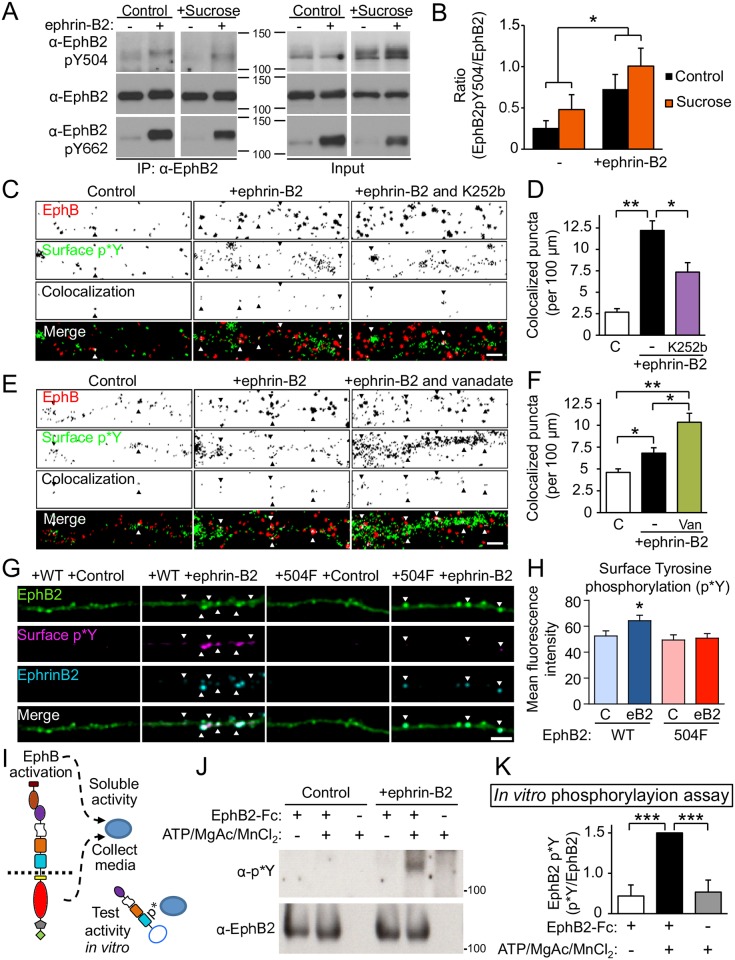
Phosphorylation of Y504 occurs on the surface of neurons.(A) Untransfected cultured rat cortical neurons treated with either ephrin-B2 (+) or control reagents (-) for 45–60 minutes and with either control (C) or sucrose (450 mM, for 15 minutes). In the left panels, EphB2 was immunoprecipitated and blots were probed (listed top to bottom) for EphB2 p*Y504, EphB2, and EphB2 p*Y662. Right panels show neuronal lysates probed in the same manner from the same experiment. (B) Quantification of the ratio of EphB2 Y504 to total EphB2 (control [n = 7] and sucrose [n = 5]; * p < 0.01, 2-factor factorial ANOVA). (C) Images of dendrites stained in live neurons for phosphotyrosine and ephrin-B binding sites (EphBs). Day in vitro (DIV) 7–10 rat cortical neurons were treated with control reagents, activated ephrin-B2 alone, or with 10 μM K252b for 45 minutes and then α-phosphotyrosine antibodies (PY99, p*Y) were added to cells at room temperature for 10 minutes. Neurons were fixed and processed for immunostaining. High-contrast images are shown. Top panels were stained for EphBs, middle panels were live-cell stained for α-p*Y and colocalization, and bottom panels show merged images. In merged panels, red staining indicates surface EphBs, green indicates p*Y, and white indicates colocalization. Arrows indicate examples of colocalized EphB and surface p*Y staining. Scale bar = 2 μm. (D) Quantification of the effects of ephrin-B2 treatment and K252b on surface p*Y staining of EphBs. n = 32, 34, and 34 fields from 3 independent experiments for control (C), ephrin B2-Fc treatment, and K252b plus ephrin-B2-Fc treatment, respectively (*p < 0.01, **p < 0.0001, ANOVA followed by Dunn’s multiple comparison test). (E) Images of live-cell stained dendrites as in (C) but treated with ephrin-B2 and vandadate (1 mM for 10 minutes). Scale bar = 2 μm. (F) Quantification of the effects of ephrin-B2 treatment and vanadate treatment on surface p*Y staining of EphB (*p < 0.01, ANOVA followed by Dunn’s multiple comparison test, n = 44 fields from 4 independent experiments). (G) DIV 7–10 rat cortical neurons transfected at DIV 3 with td-Tomato and enhanced yellow fluorescent protein (EYFP)-tagged EphB2 wild type (WT), Y504E, or Y504F were treated with either control reagents or activated ephrin-B2 for 45 minutes and then α-phosphotyrosine antibodies (PY99, p*Y) were added to cells at 37°C for 10 minutes. Neurons were fixed and processed for immunostaining. High-contrast images are shown. Top panels were stained for EYFP-tagged EphB2, upper middle panels were live-cell stained for α-p*Y, and lower middle panels were stained for Fc (control Fc or ephrin-B2). Bottom panels show merged images. Arrows indicate examples of triple colocalized puncta. Scale bar = 3 μm. (H) Quantification of the mean fluorescence intensity of surface phosphotyrosine for each condition (n = 20 fields from 3 independent experiments, *p < 0.05, ANOVA followed by Dunn’s multiple comparison test). (I) Experimental approach for EphB2 extracellular phosphorylation activity assay in neurons is illustrated. (J) Tyrosine kinase activity in ephrin-B2–treated conditioned artificial cerebrospinal fluid (ACSF) in cultured rat cortical neurons. Medium of cultured neurons was replaced with ACSF, and neurons were treated with ephrin-B2 or control reagents for 45–60 minutes. The extracellular domain of EphB2 fused to the Fc fragment of immunoglobulin G or control reagent was added to filtered ACSF. To activate the activity released from cultured neurons into ATP, MgAc and MnCl2 were added. EphB2-Fc was precipitated with Protein G agarose and probed for α-phosphotyrosine (PY99). ACSF was heated to 37°C for 1 hour. Blots were probed as shown. (K) Quantification of the effect of ephrin-B2 treatment in cultured neurons and addition of ATP, MgAc, and MnCl2 to isolated conditioned ACSF on the tyrosine phosphorylation of EphB2-Fc (p < 0.005, ANOVA followed by Fisher’s exact test, n = 4).